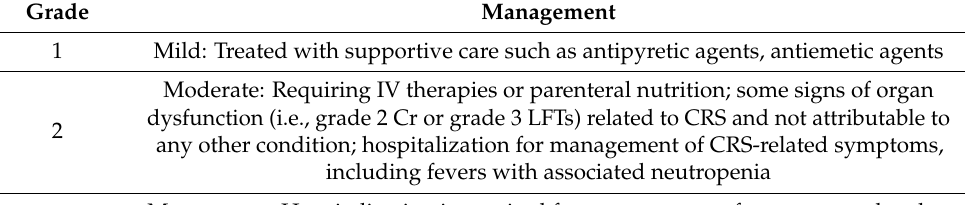
Table 2. Penn grading scale for CRS